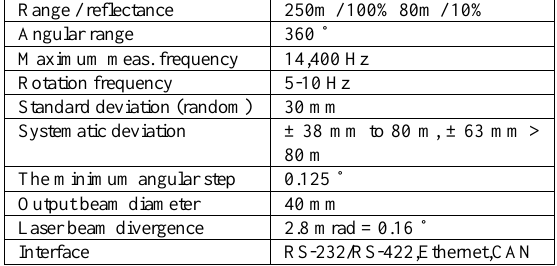
Table 2. Sick LD LRS1000